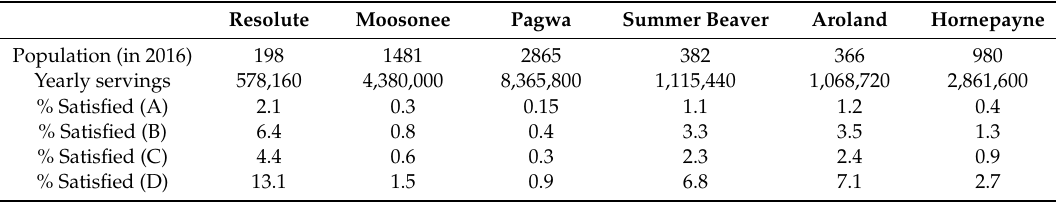
Table 10. Yearly servings of vegetables satisfied per greenhouse